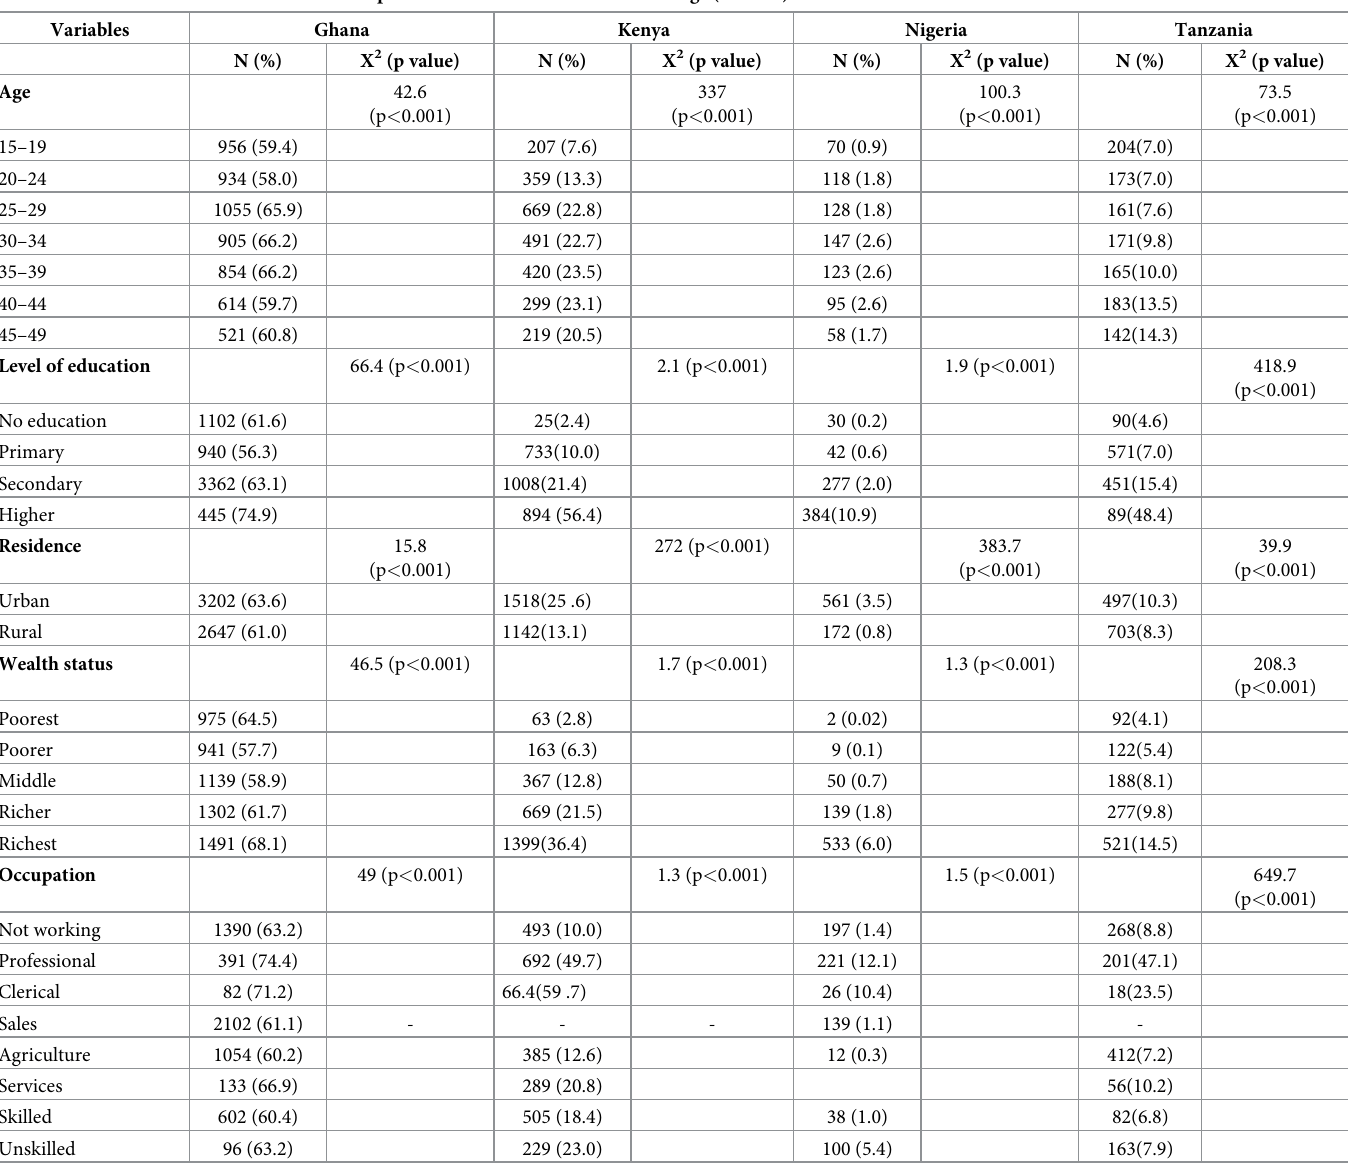
Table 1. Socio-economic characteristics of respondents and health insurance coverage